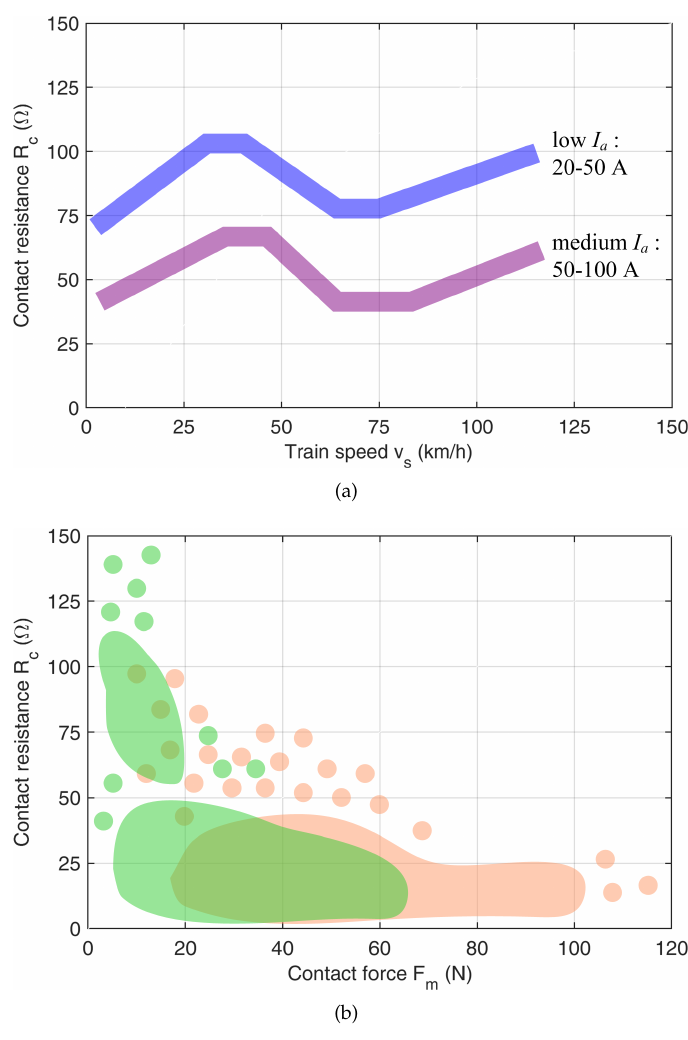
Figure 5. Dynamic contact resistance R c ( a ) vs. arc current I a (blue and purple curves for low and medium arc current ranges) for an applied contact force of 60N to 80N, and ( b ) vs. contact force F m (data for graphite strip are in green and for Kasperovski strip in light brown, tested at 200A DC